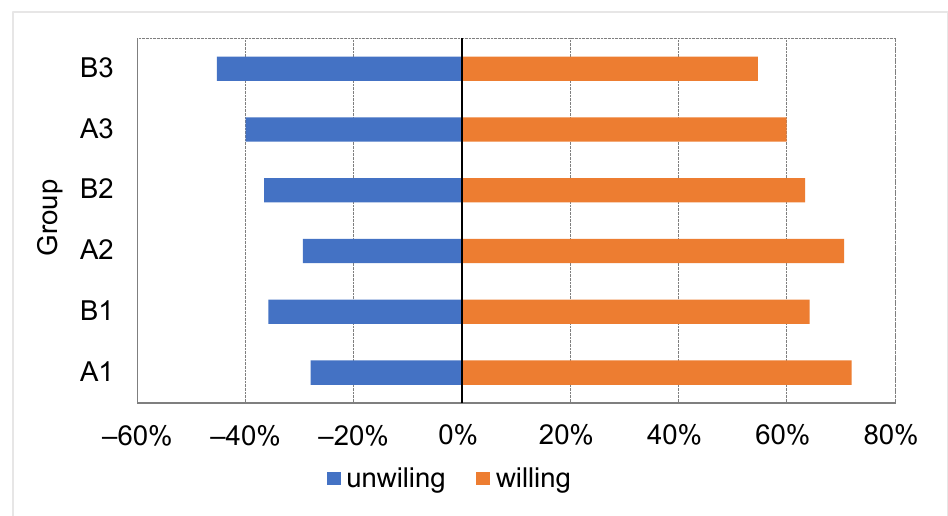
Figure 10. Percentage distribution of willingness to work for six groups. The students who were reluctant to work indicated factors that would positively affect their attitude to work. Some people responded that they felt reluctant to work but did not give an answer as to what would make them change attitude. The received responses were divided into 6 categories and presented in Figure 11.